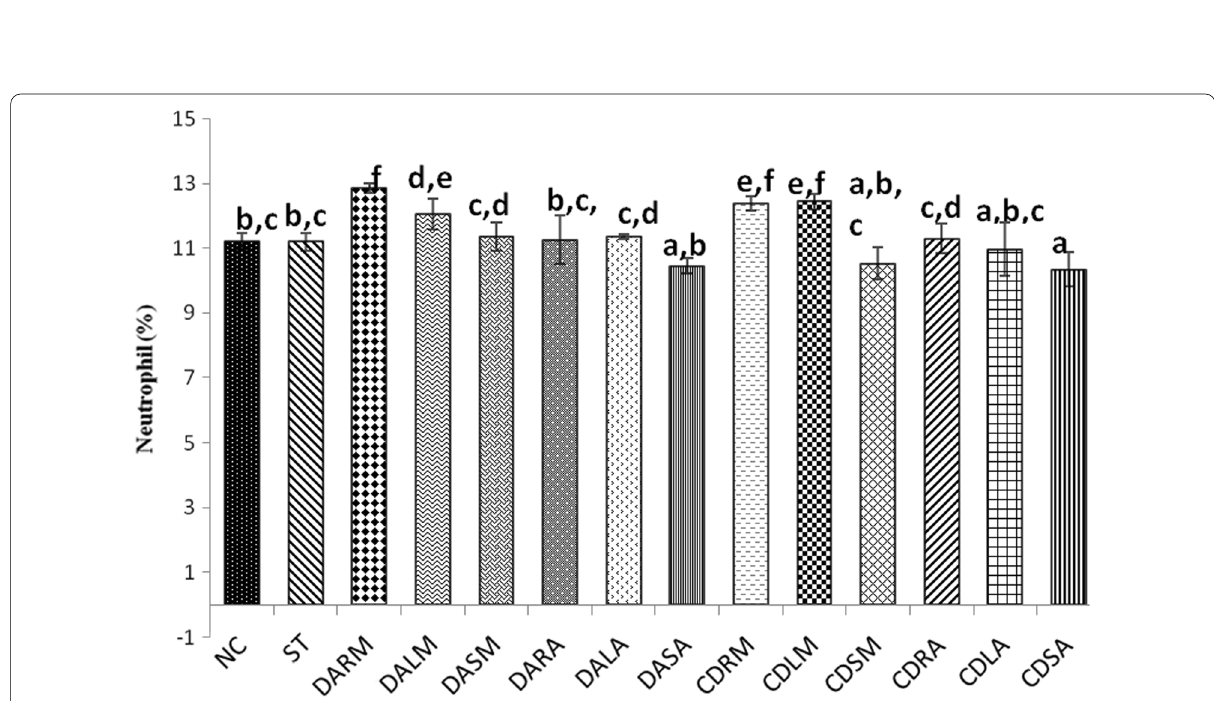
Fig. 5 Effects of methanolic and aqueous extracts of roots, leaves and stem of D. arborescens and C. dependens on mean corpuscular haemoglobin (MCH) of albino rats. Bars with similar alphabets are not statistically different ( p < 0.05)